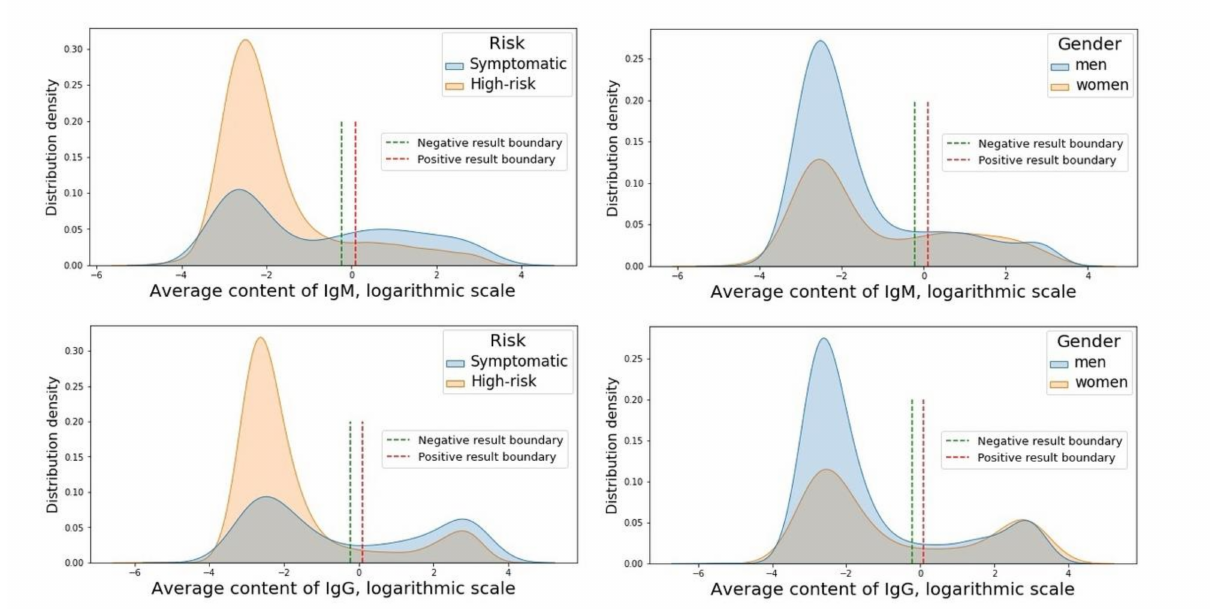
Figure 1. Distribution of IgM and IgG content with two peaks on both sides of the boundaries of the reference interval among persons from the symptomatic and high-risk groups and men and